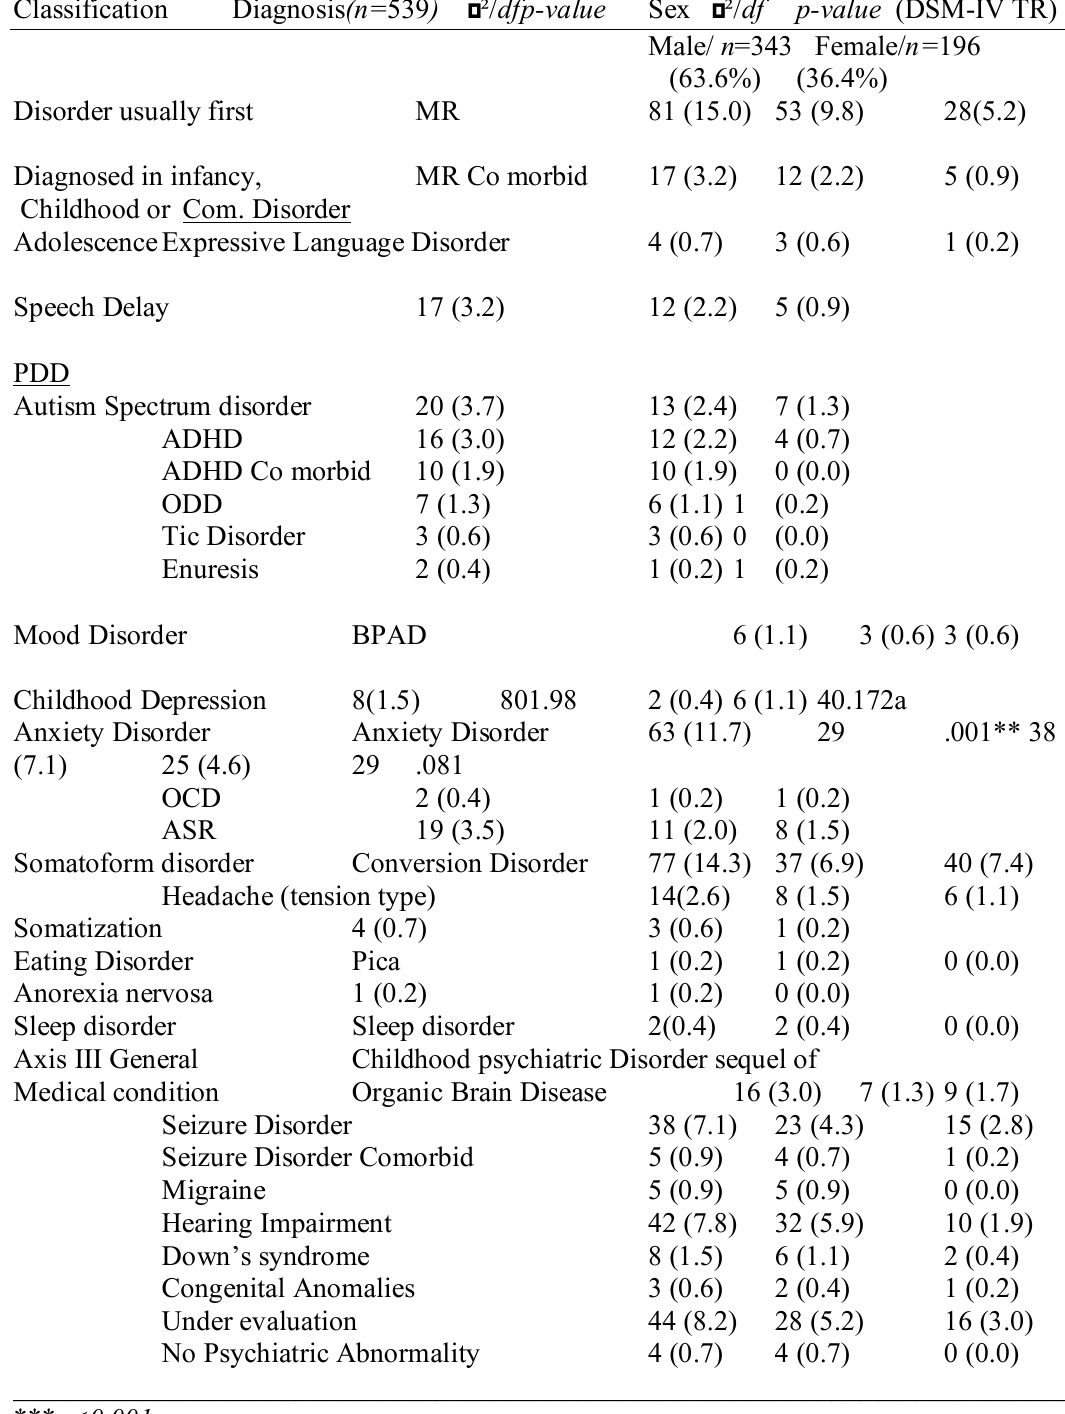
Table 4: Prevalence of childhood psychiatric disorder and cases of boys and girl with the